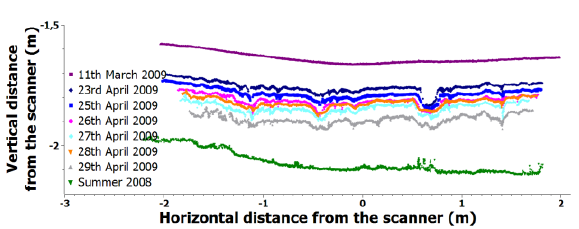
Figure 7. The snow surface profiles from Tähtelä at each date of laser scanning. Each profile represents the snow surface height of one measurement. The Summer 2008 measurement represent the ground level. The scanner is at the coordinates 0,0.